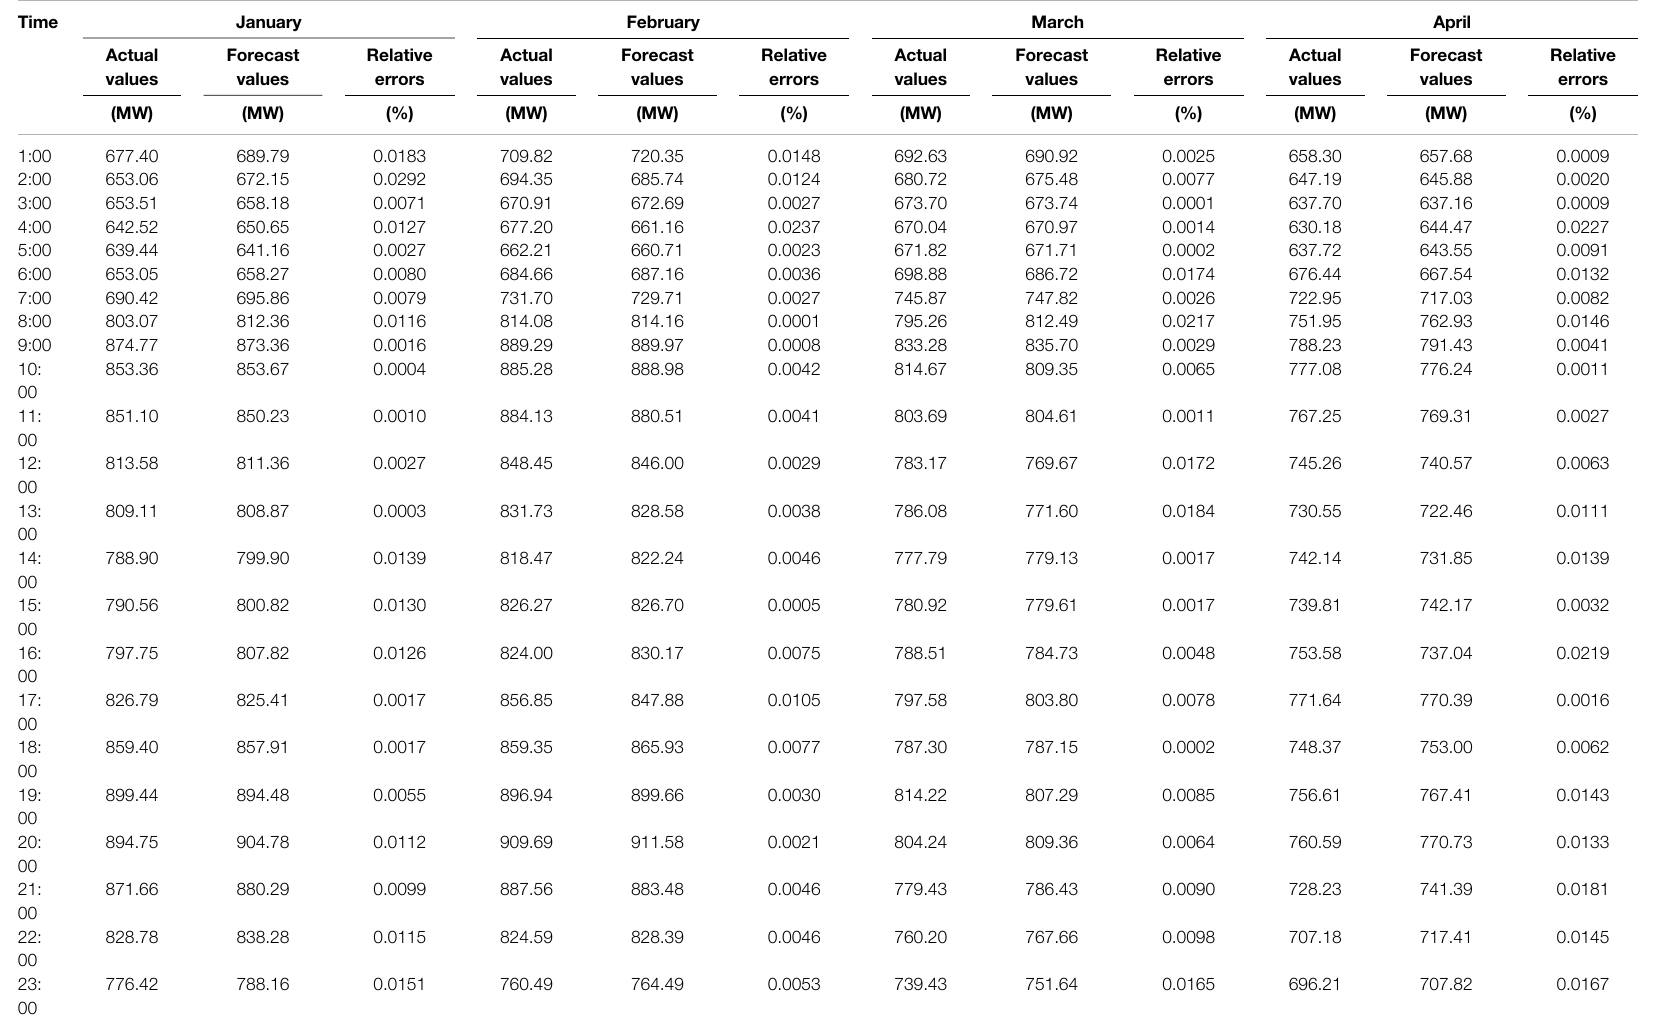
TABLE 4 | Forecast results of power